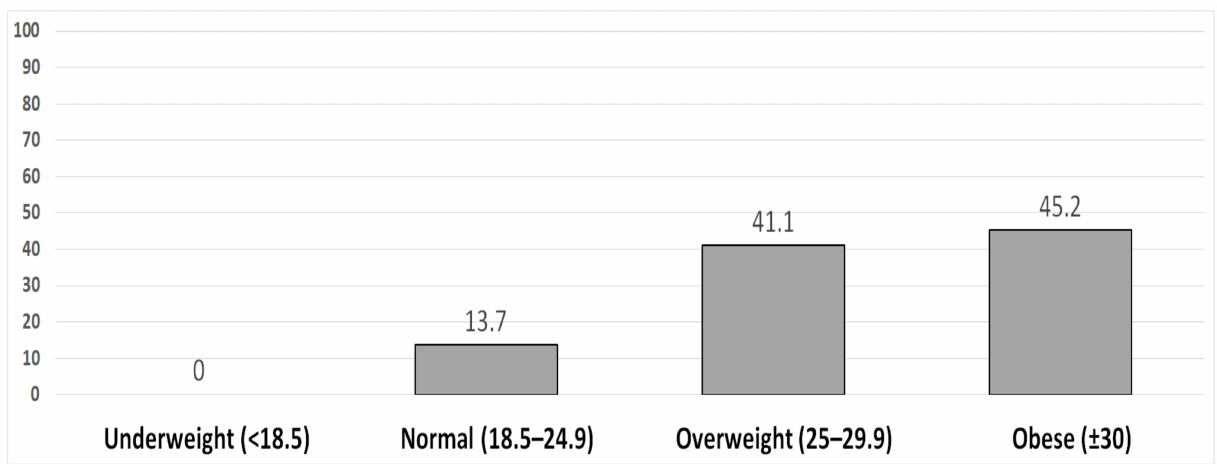
Figure 1. Subjects’ body mass index (kg/m 2